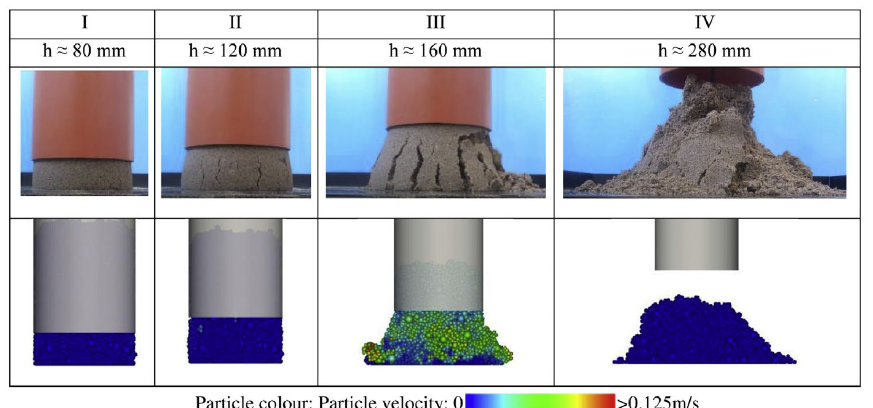
Figure 10. The lifting cylinder test for cohesive material as performed by [91]. Reproduced with permission from Particuology; published by Elsevier,